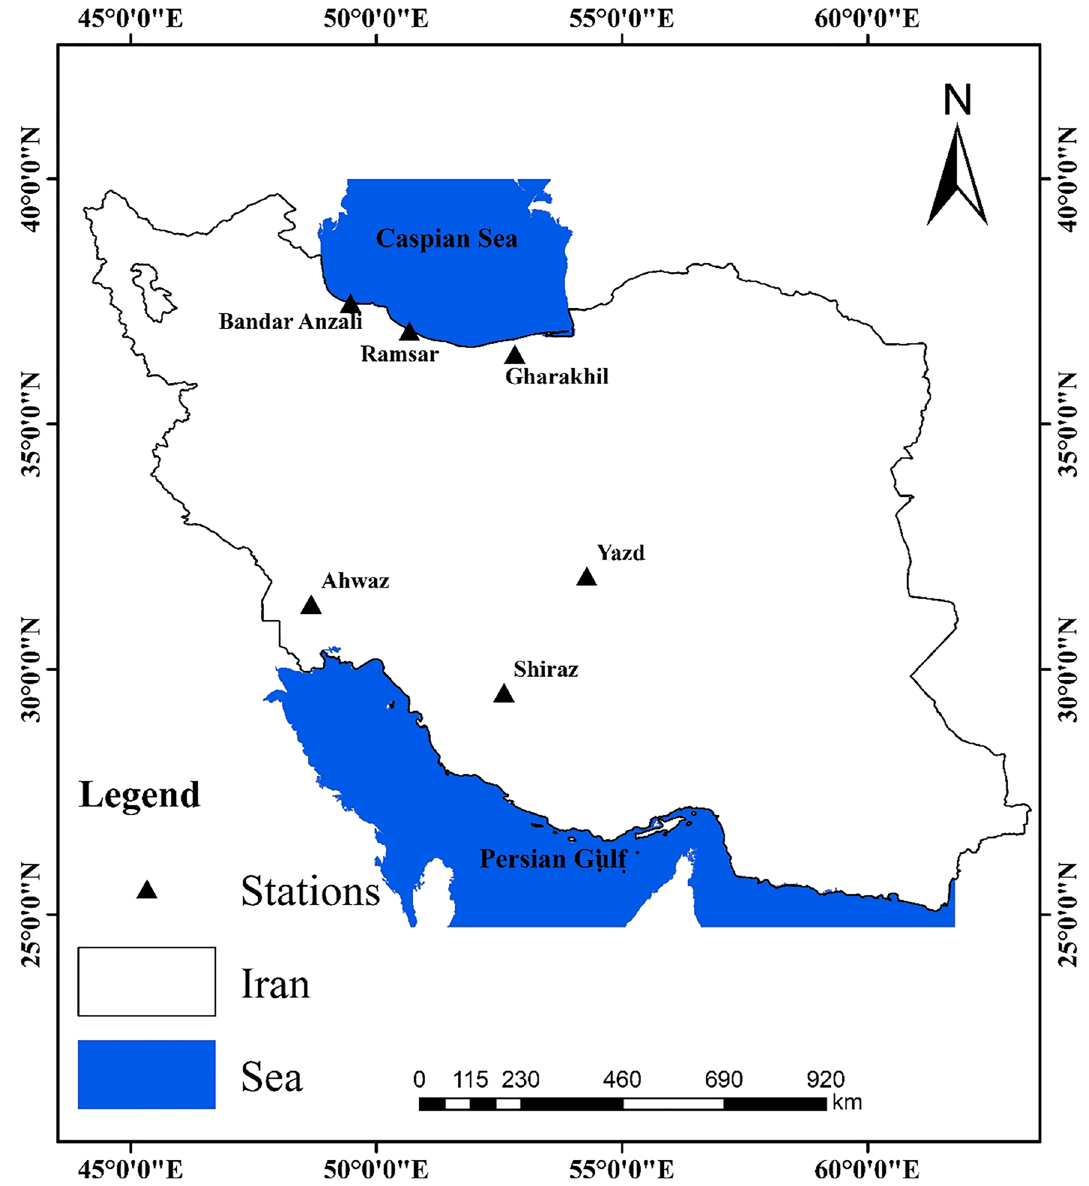
Figure 1. Location of the stations under investigation on the country (the map is generated in R software by the